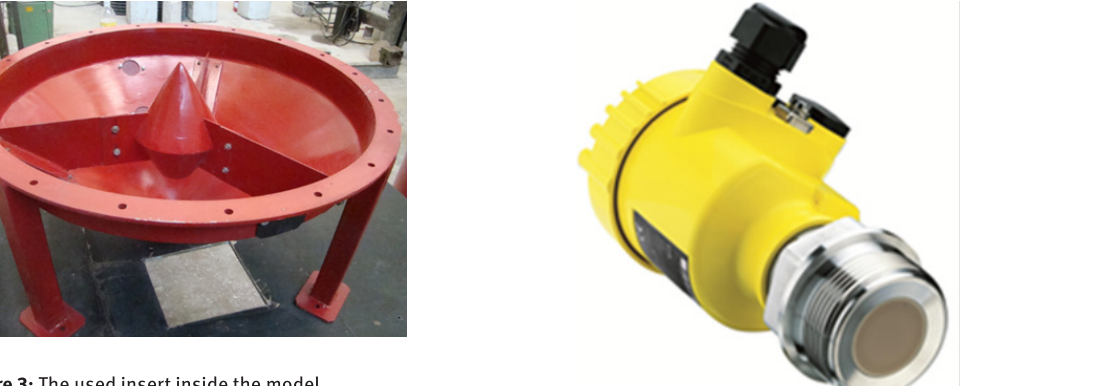
Figure 3: The used insert inside the model.